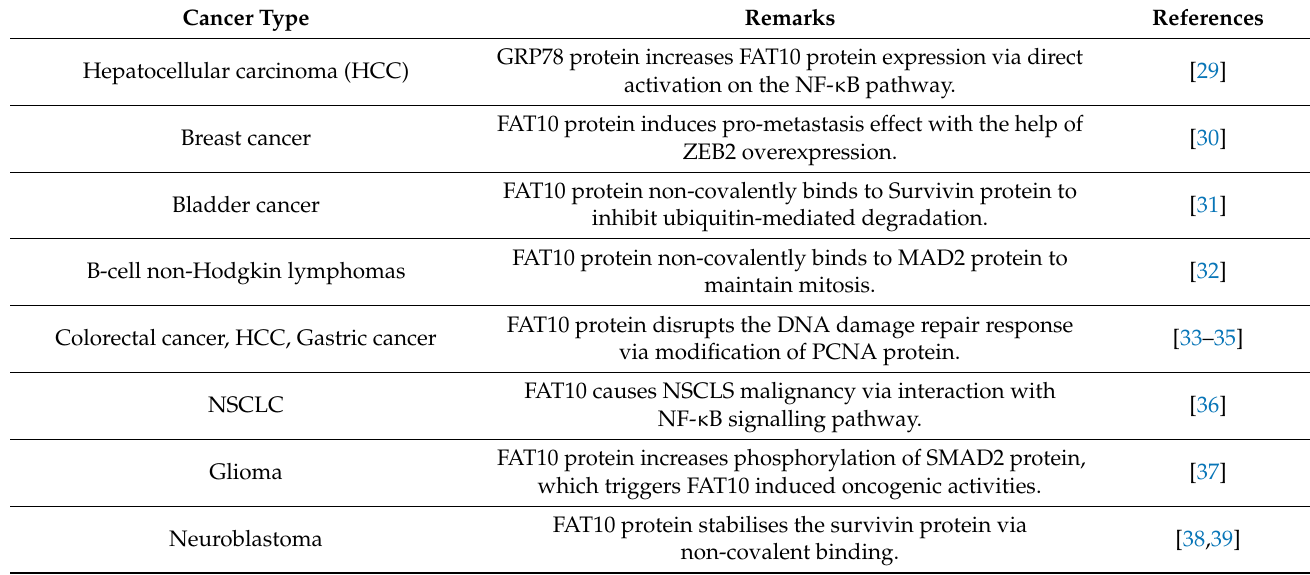
Table 1. The actions of FAT10 protein and its involvement with target proteins and pathway in various cancer types; Hepatocellular carcinoma (HCC); 78-kDa glucose-regulated protein (GRP78); Nuclear factor- κ B (NF- κ B); zinc finger E-box binding protein 2 (ZEB2); mitotic arrest deficient 2 (MAD2); Proliferating cell nuclear antigen (PCNA); SMAD Family Member 2 (SMAD2); Non-small cell lung cancer